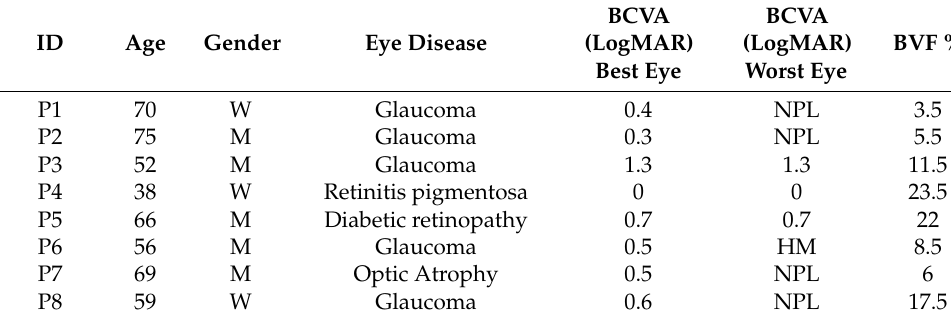
Table 2. Patients with peripheral vision loss